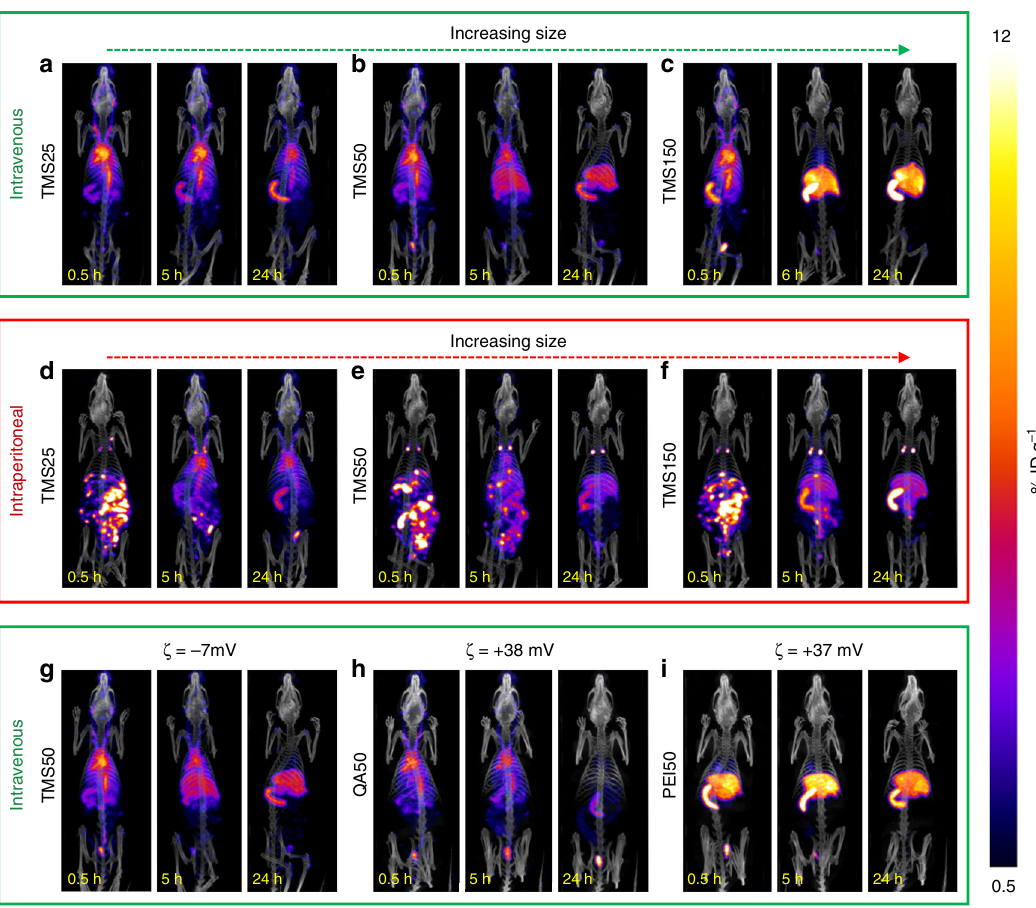
Fig. 2 SPECT/CT images showing the whole-body spatio-temporal evolution of MSNs. PEG-TMS-coated MSNs of nominal sizes 25 nm ( a , d ), 50 nm ( b , e ), 90 nm (Supplementary Fig. 6), and 150 nm ( c , f ) were injected via. i.v. ( a – c , Supplementary Fig. 6) or i.p. ( d – f ) route to understand the effect of MSN size and route of administration. PEG-PEI-coated and PEG-QA-coated MSNs, namely, QA50 ( h ) and PEI50 ( i ), were administered i.v. to explore the effect of surface chemistry. Note that ( b ) and ( g ) are identical images (shown twice for ease of comparison). Also, TMS50 ( b ) and QA50 ( h ) were compared to understand the effect of zeta potential on disposition of MSNs. Injections were followed by SPECT/CT imaging at 30 min, 5 h (6 h in case of TMS150 (i.v.)), and 24 h. All SPECT images were scaled from 0.5 to 12%ID g − 1 . Note: TMS90 MSN was not injected i.p.; lymph nodes and abdominal aorta were not analyzed as ROIs in the i.v. and i.p. cases,